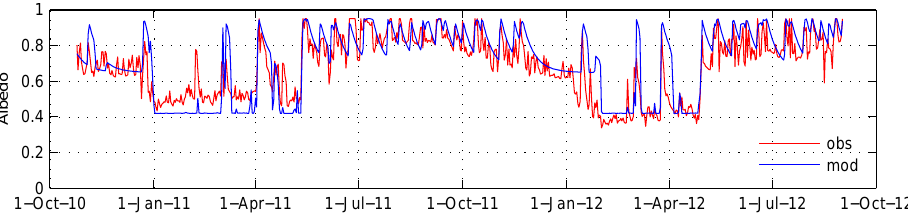
Figure 2. Daily average albedo observed at AWS glacier (red) during the measurement period and modelled in SEBpr (blue) using the expressions of Oerlemans and Knap (1998), with locally optimized